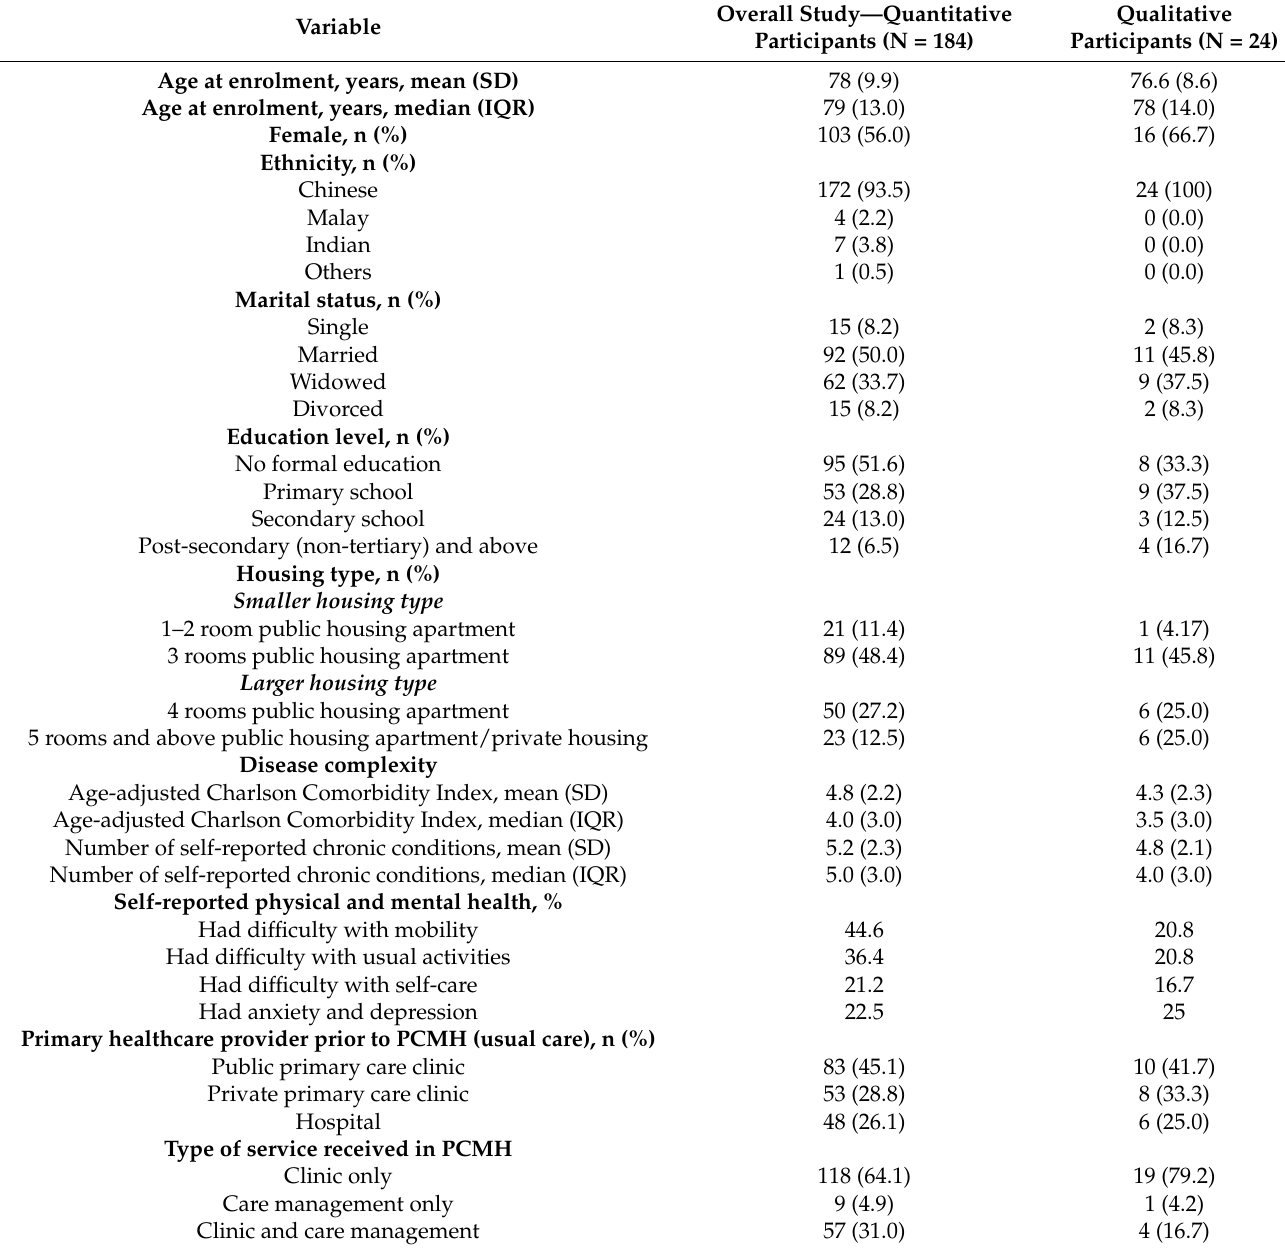
Table 1. Baseline sociodemographic characteristics of study